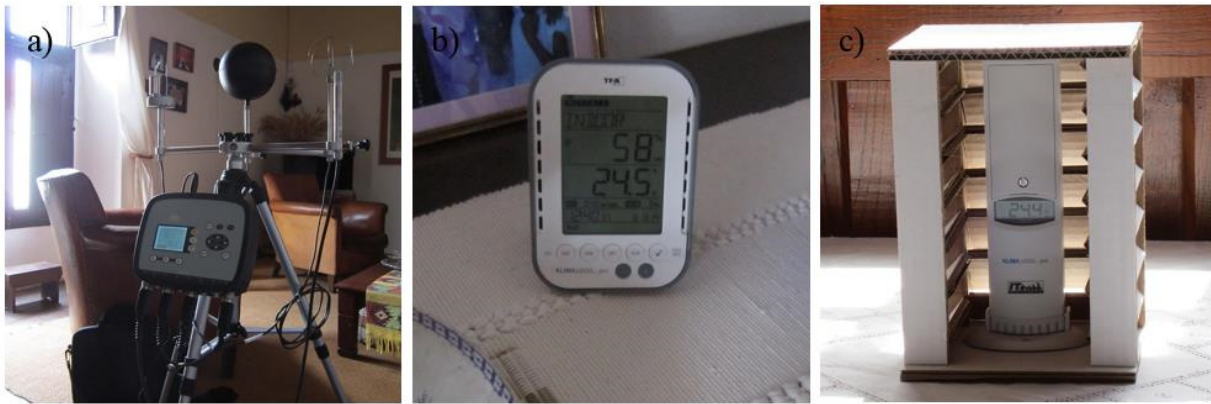
Figure 3. ( a ) Thermal microclimate station; ( b ) thermo-hygrometer + datalogger; ( c ) thermo-hygrometer